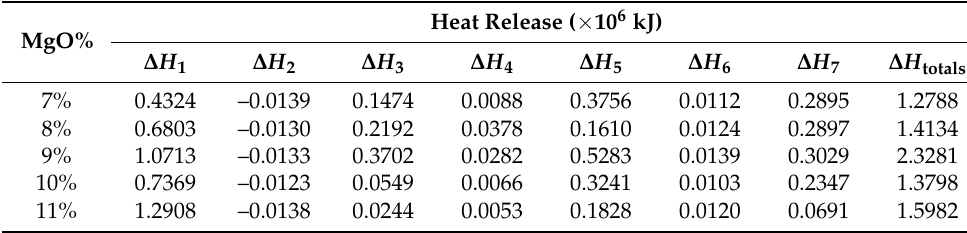
Table 3. Heat release of per ton of BF slag from 1400 ◦ C to 35 ◦